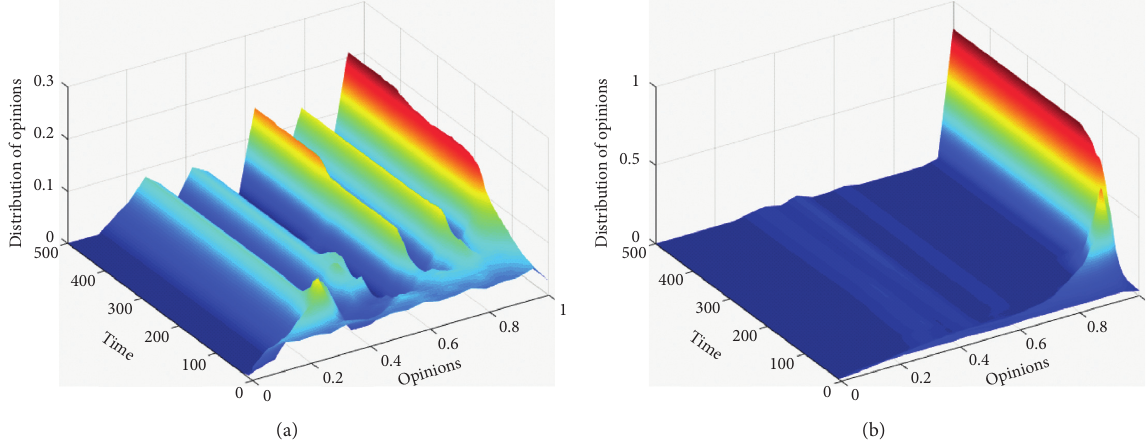
Figure 6: Group opinion distribution evolution in the nearest-neighbor coupled network. Group polarization is formed when d (a) d m � 0 . 3. (b) d m � 0 .